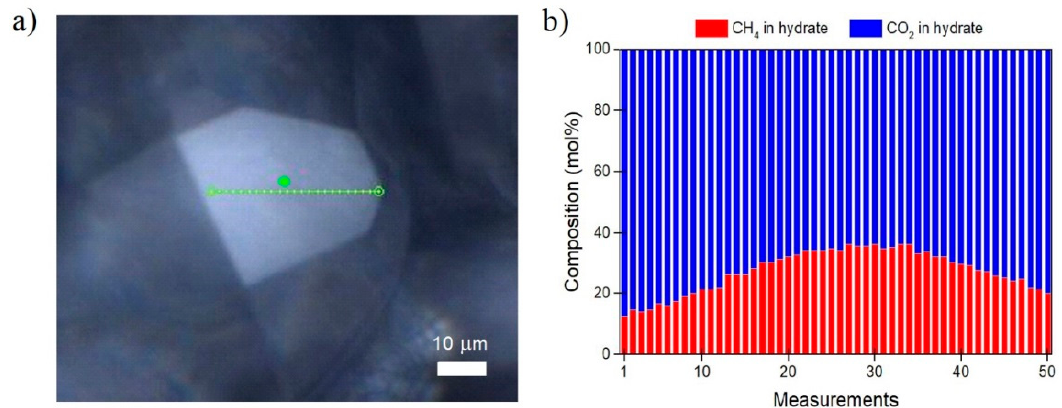
Figure 7. ( a ) Raman line scan across hydrate crystal surface was scanned step-by-step in one direction. ( b ) Composition variations for the CH 4 and CO 2 encased into the hydrate phase at 50 measuring points across the formed hydrate crystal. The standard deviation for the line mapping was 0.2 mol%.